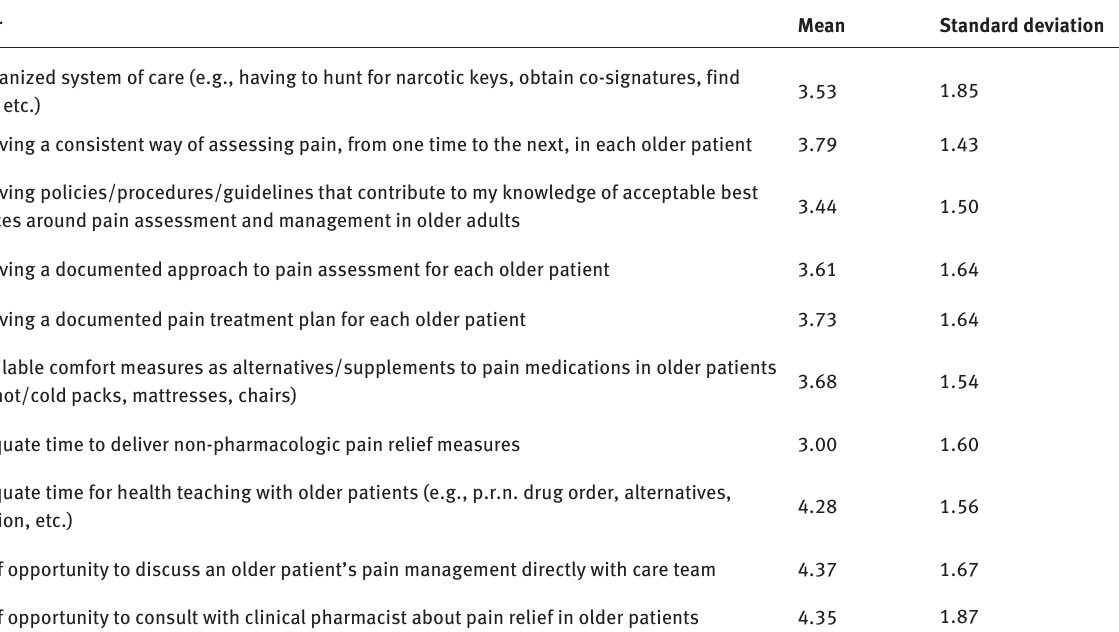
Table 2: Characteristics of the frequency of barriers to optimum pain assessment and management in elderly patients related to the health- care system.